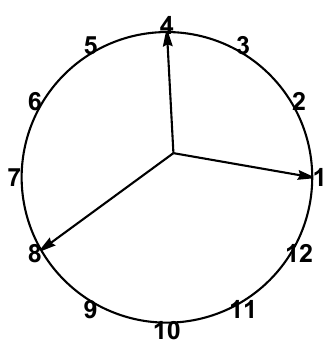
Figure 2 . The tripod (1,4,8) for n = 12